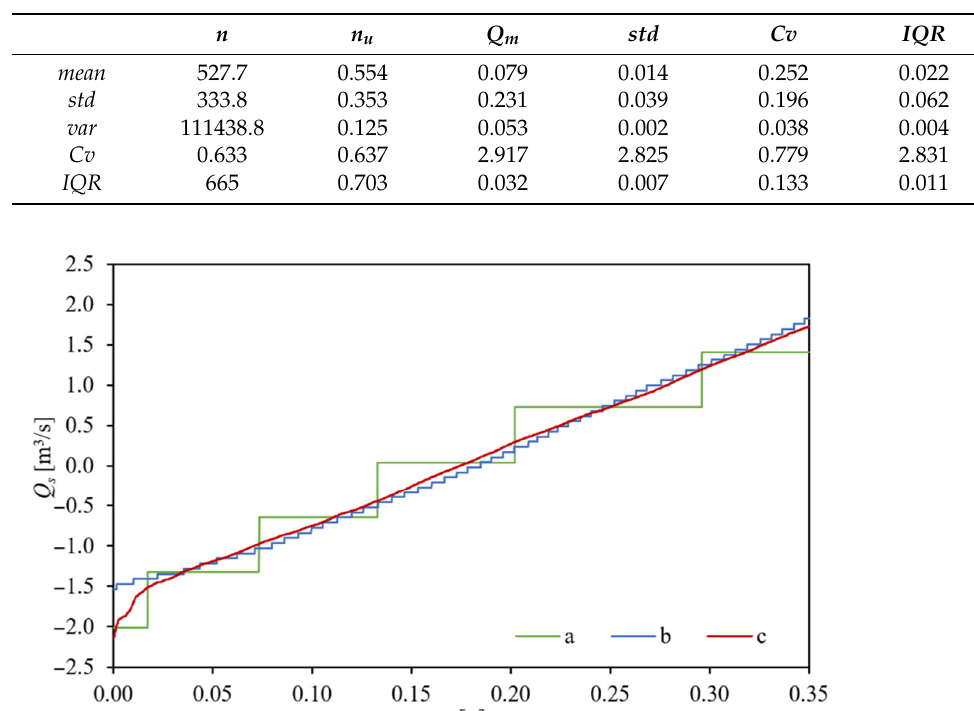
Table 1. Characteristics of the lowest 10% of values from the study data. n —number of data points;